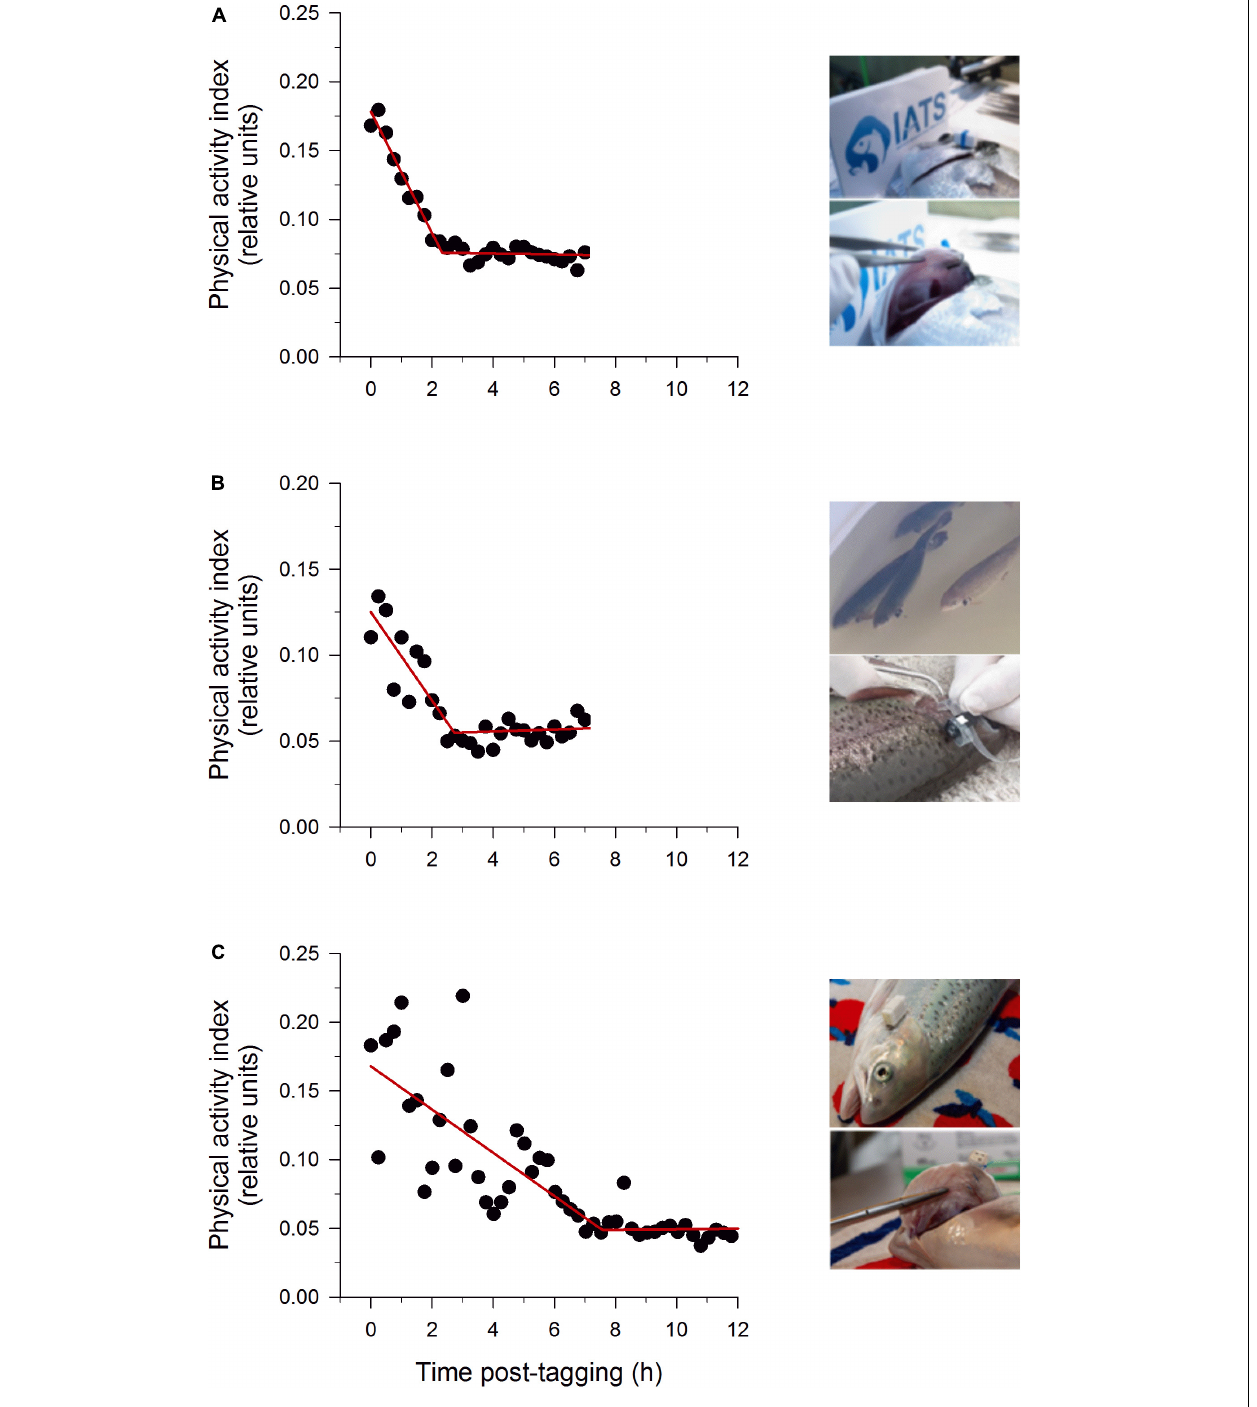
FIGURE 2 | AEFishBIT records of physical activity of a representative individual, (A) gilthead sea bream; (B) rainbow trout; (C) Atlantic salmon) after tagging and return to the tank. Measures (black circles) were taken every 15 min. Lines represent piecewise linear fit of data with one break point. Inserts show the operculum attachment in 200–300 g gilthead sea bream (monel tags with a flexible heat shrink polyethylene tube), 550–650 rainbow trout (heat shrink polyethylene tube ring 2 weeks after suture) and 700–800 g Atlantic salmon (suture and heat shrink polyethylene tube ring in a single step). Partially adapted from data of Kolarevic et al. (2021) and Rosell-Moll et al.